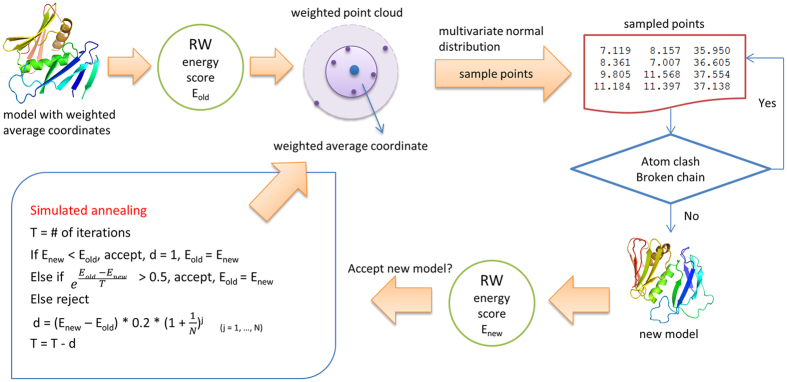
The workflow of the stochastic point cloud method for sampling conformations.Starting from an initial model comprised of the weighted average coordinates of template structures, its RW energy is calculated as Eold, weighted point clouds are constructed for unfixed residues whose conformations are uncertain. New positions are sampled for unfixed residues from the multivariate normal distribution representing the point clouds, the positions with few or no atom clashes or broken chain are accepted to generate a new model. The new model is accepted based on the difference between its energy Enew and the old energy Eold according to a simulated annealing protocol, and the accepted model is used as the initial model for the next round of modeling, which is repeated until reaching a fixed number of iterations.